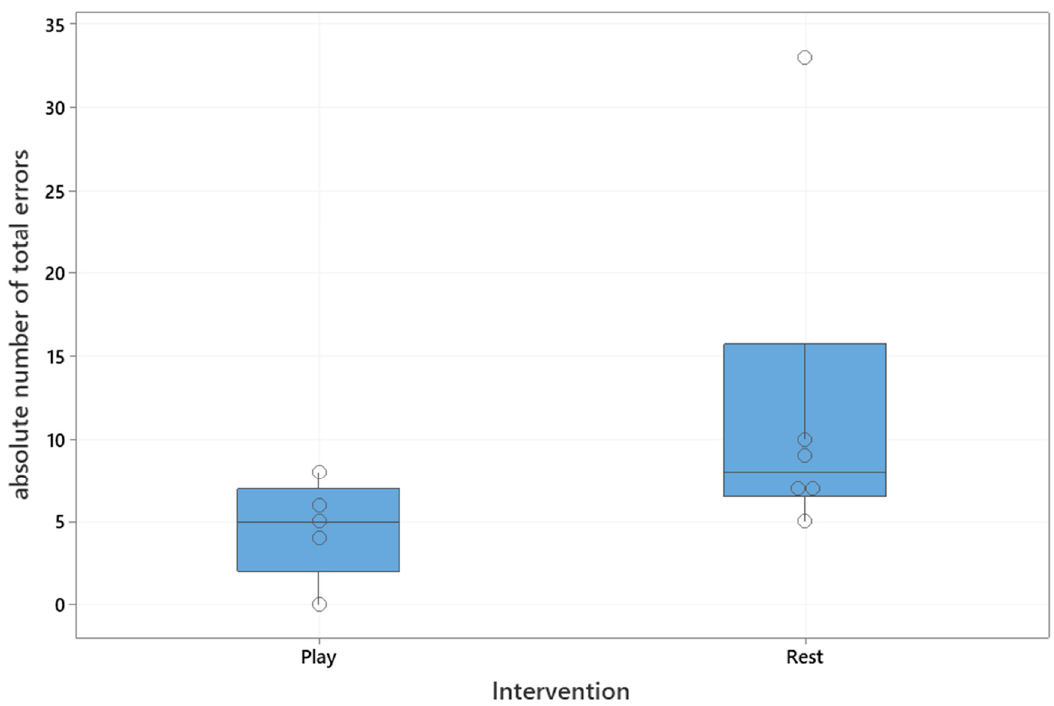
Figure 3. Boxplot of the absolute number of total errors to reach the training criterion based on intervention. Boxplots show the median and interquartile range from the 25th to 75th interquartile. Open circles represent individual dogs. Play: Playful activity group, Rest: resting group.